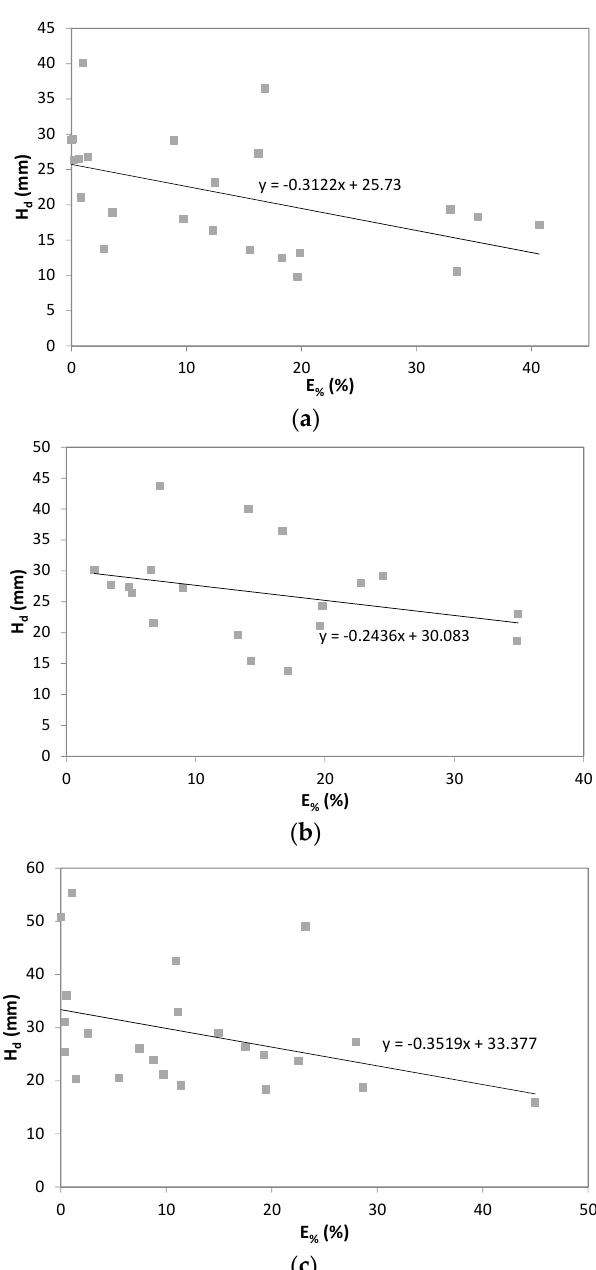
( a ) ( b ) Figure 11. Relation between annual maximum rainfall depth, H d , and underestimation error, E % . ( a ) San Biagio della Valle station, t a = d = 30 min. ( b ) Compignano station, t a = 15 min and d = 30 min. The best interpolating linear function is also plotted. 4.4. Correction Procedure When a series of n annual maximum rainfall depths, (cid:1834) (cid:3031) (cid:3284) ( i = 1, …, n), of assigned duration d obtained from data characterized by coarse t a has to be corrected, the steps below are followed.